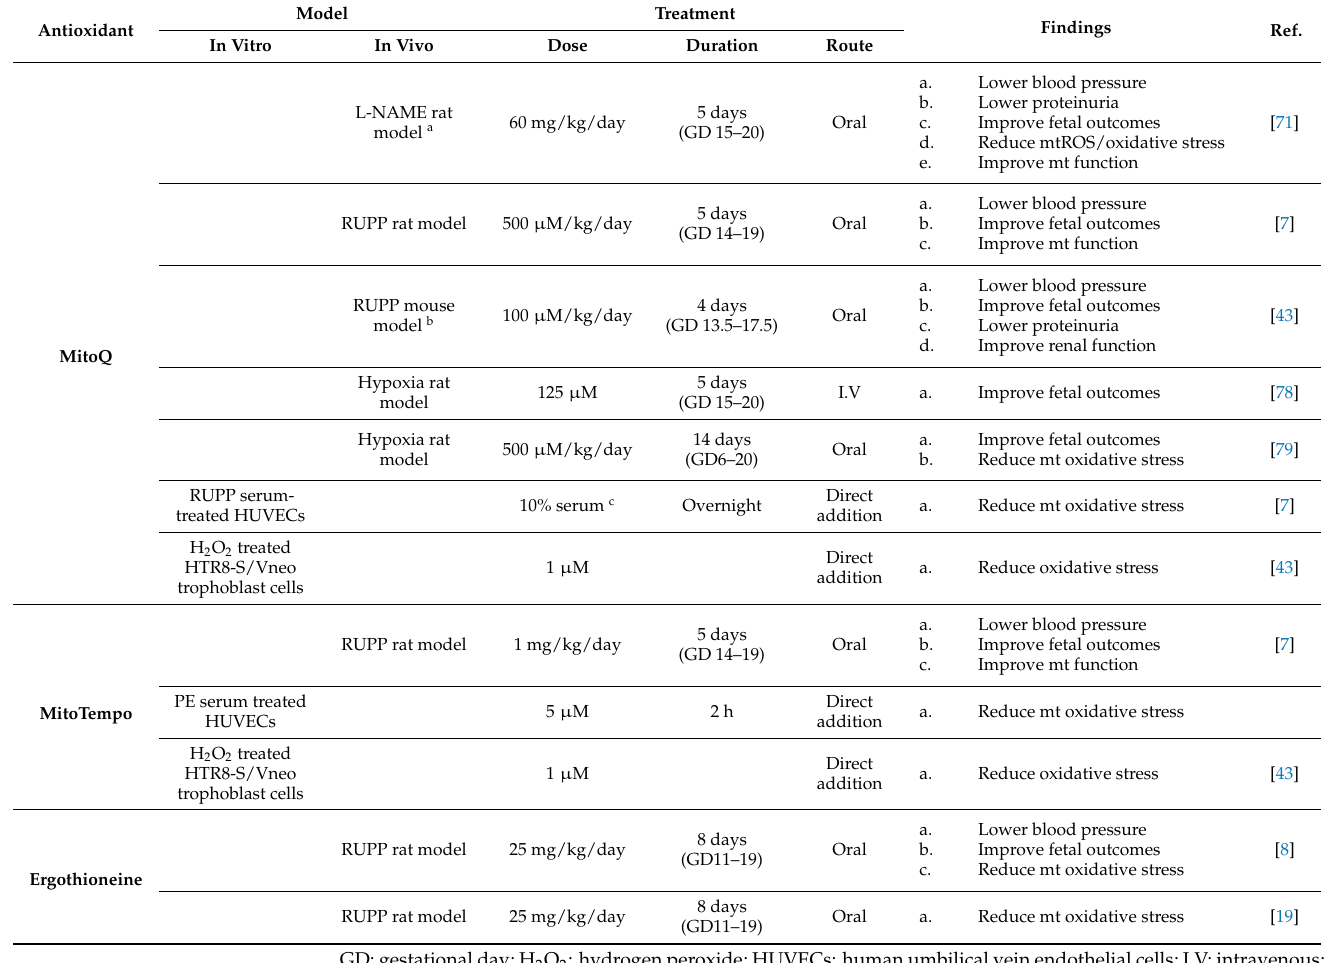
Table 1. Studies assessing mitochondrial antioxidants in preeclamptic